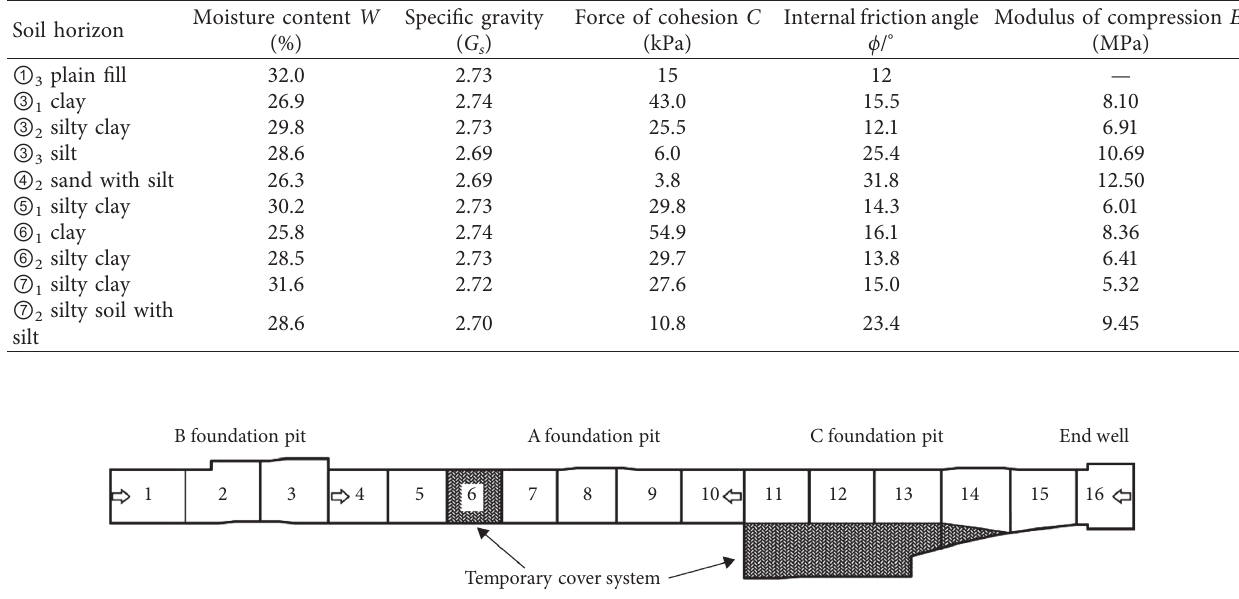
Figure 2: Sectional construction drawing of the station foundation pit. Table 2: Soil layer and structural parameters.